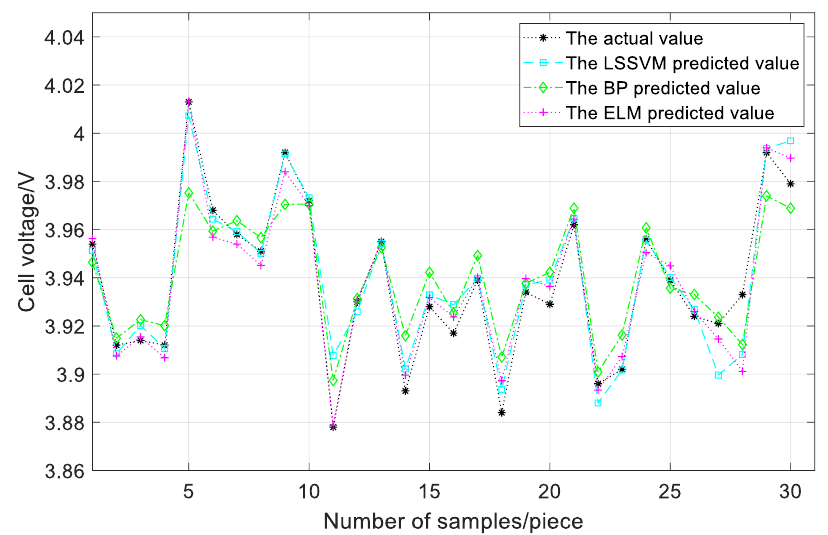
Figure 7. Prediction result for cell voltage with different models.